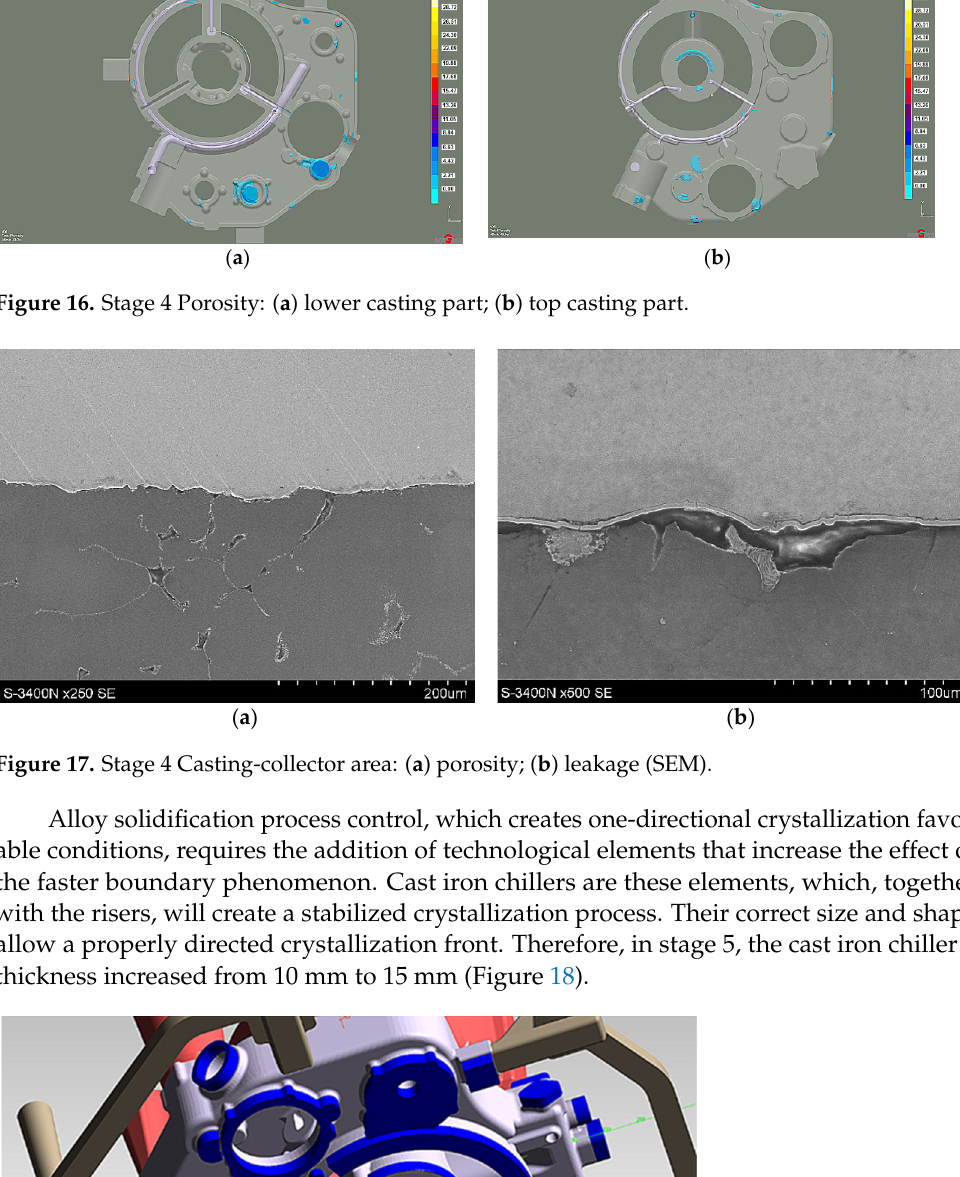
Figure 15. Stage 4 Microporosity criterion: ( a ) the system without feeding elements; ( b ) the system with top feeding risers.